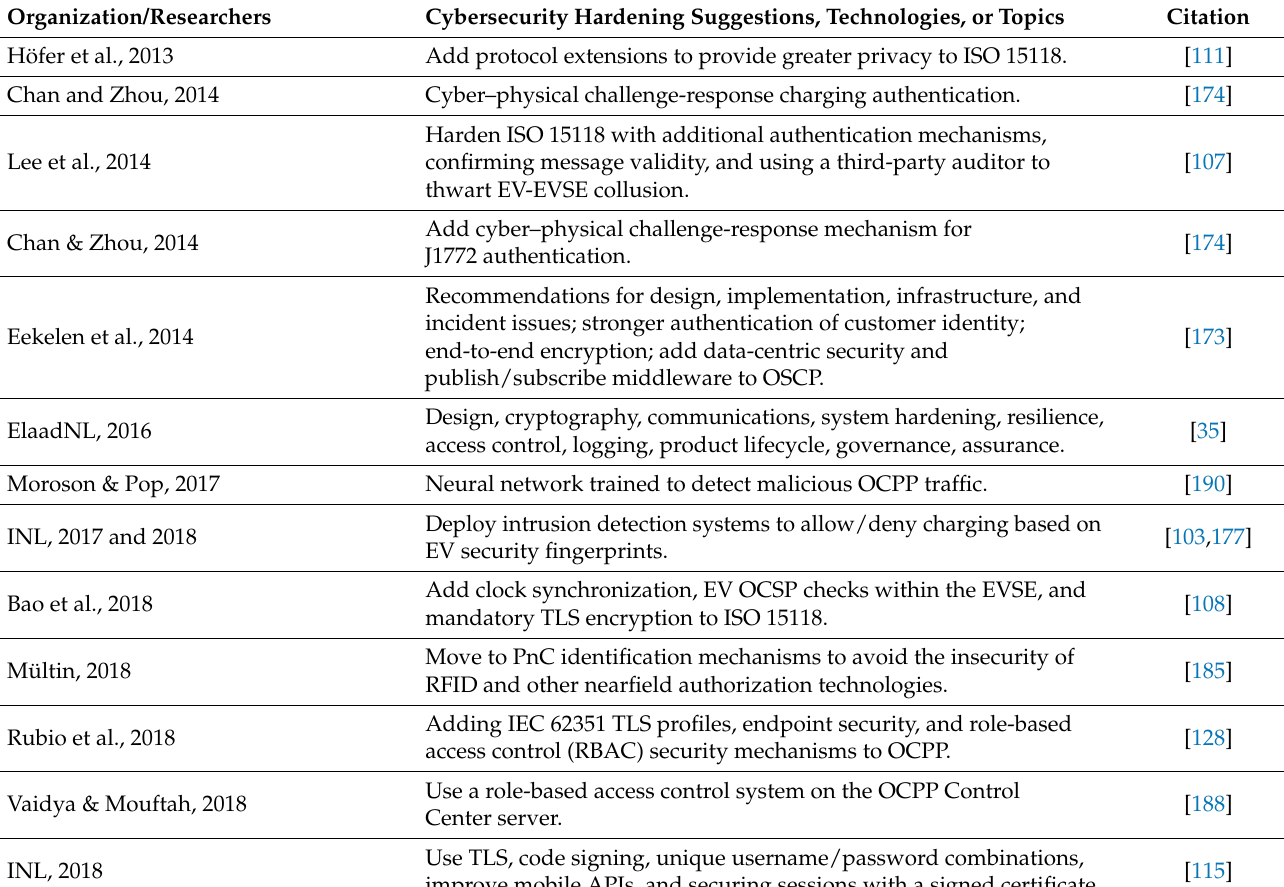
Table 6. EVSE cybersecurity defense